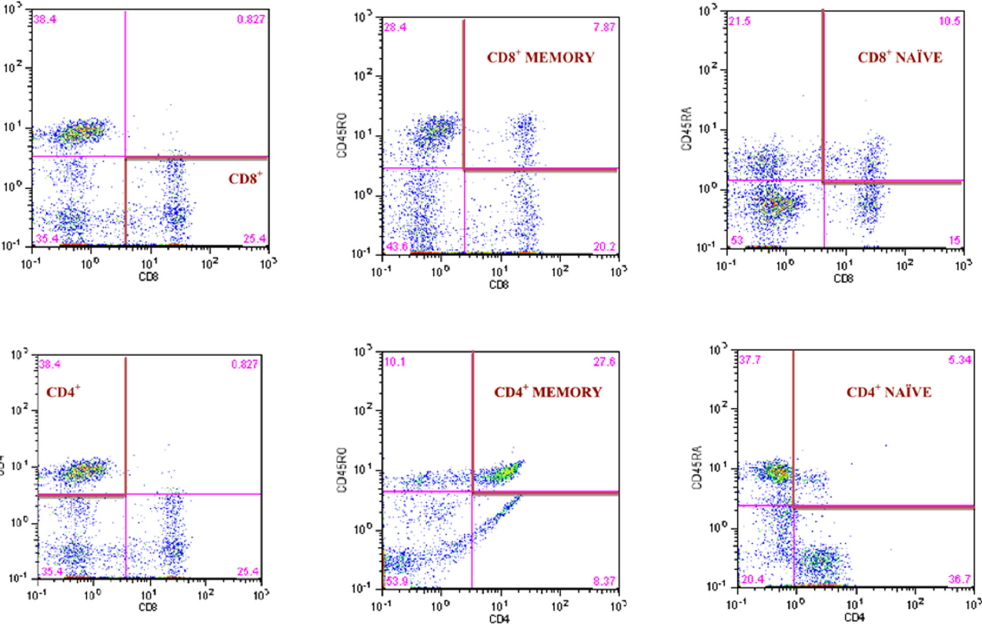
Figure 2. Gating strategy for identifying the CD4 + and CD8 + T lymphocyte and the frequency of CD4 + and CD8 + naïve and memory T lymphocytes.